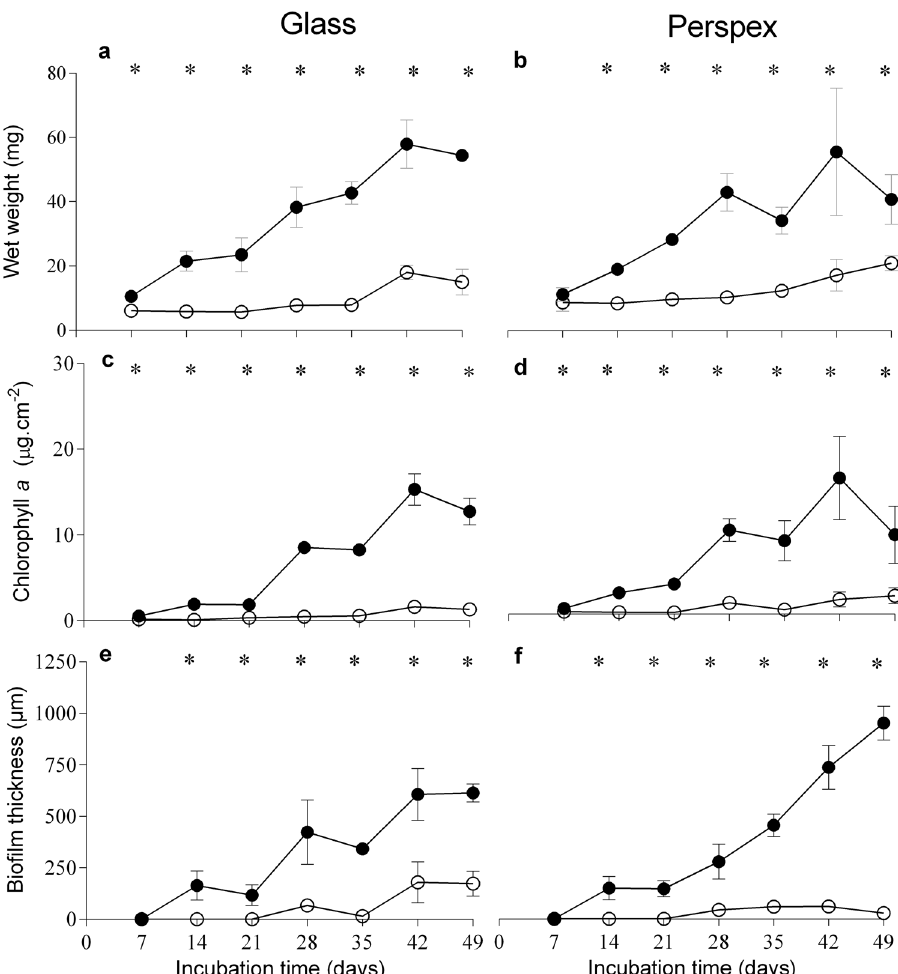
Fig. 2 Evaluation of Toxi fi lum sp. LEGE 06021 bio fi lm development. The parameters analysed refer to wet weight ( a , b ), chlorophyll a quanti fi cation ( c , d ) and bio fi lm thickness ( e , f ). Bio fi lms were formed in glass ( a , c , e ) or perspex ( b , d , f ), at two average shear rates, 4 s − 1 (closed circles) and 40 s − 1 (open circles) for 49 days. Standard deviations from two biological assays with three replicates each are represented. Symbol * indicate statistically different values for P < 0.05 (unpaired t -tests) at each incubation